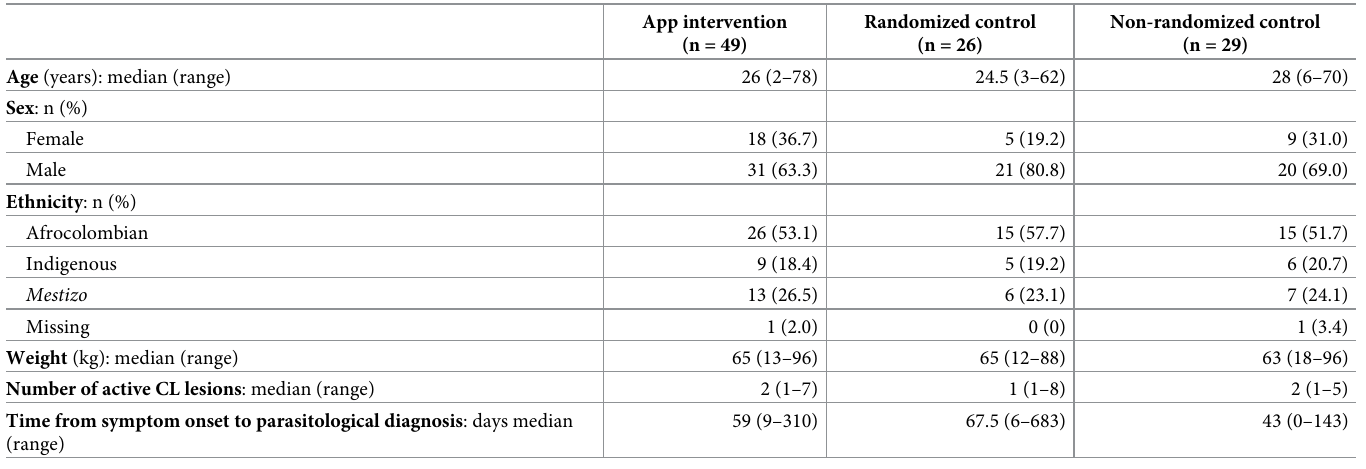
Table 1. Baseline characteristics of study participants (n =